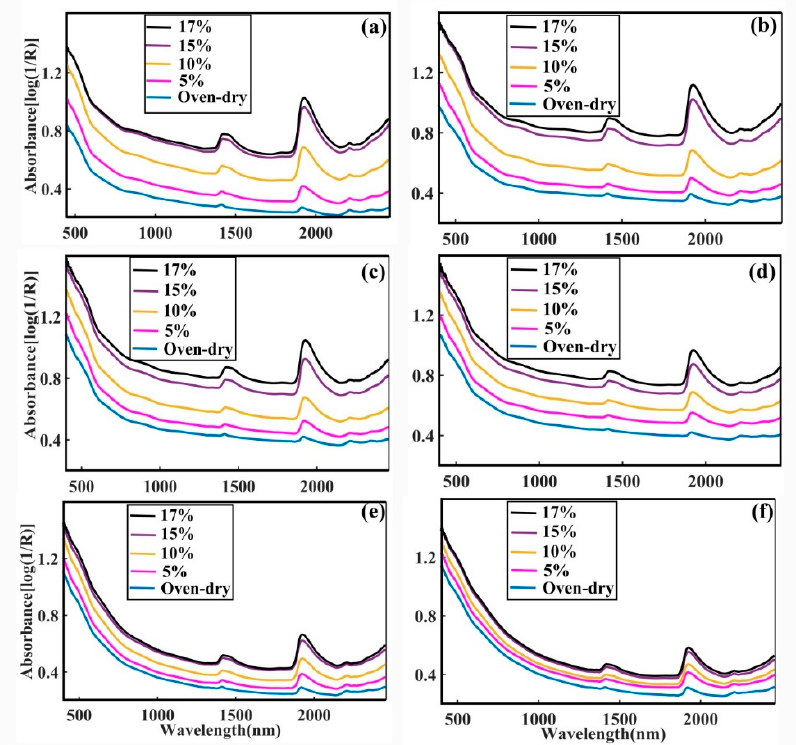
Figure 4. Shows the raw absorbance plots of soil samples that dosed by various moisture levels for the soil organic matter (SOM) content of: ( a ) 0.40%, ( b ) 1.12%, ( c ) 2.12%, ( d ) 3.35%, ( e ) 4.51% and ( f ) 7.92%.